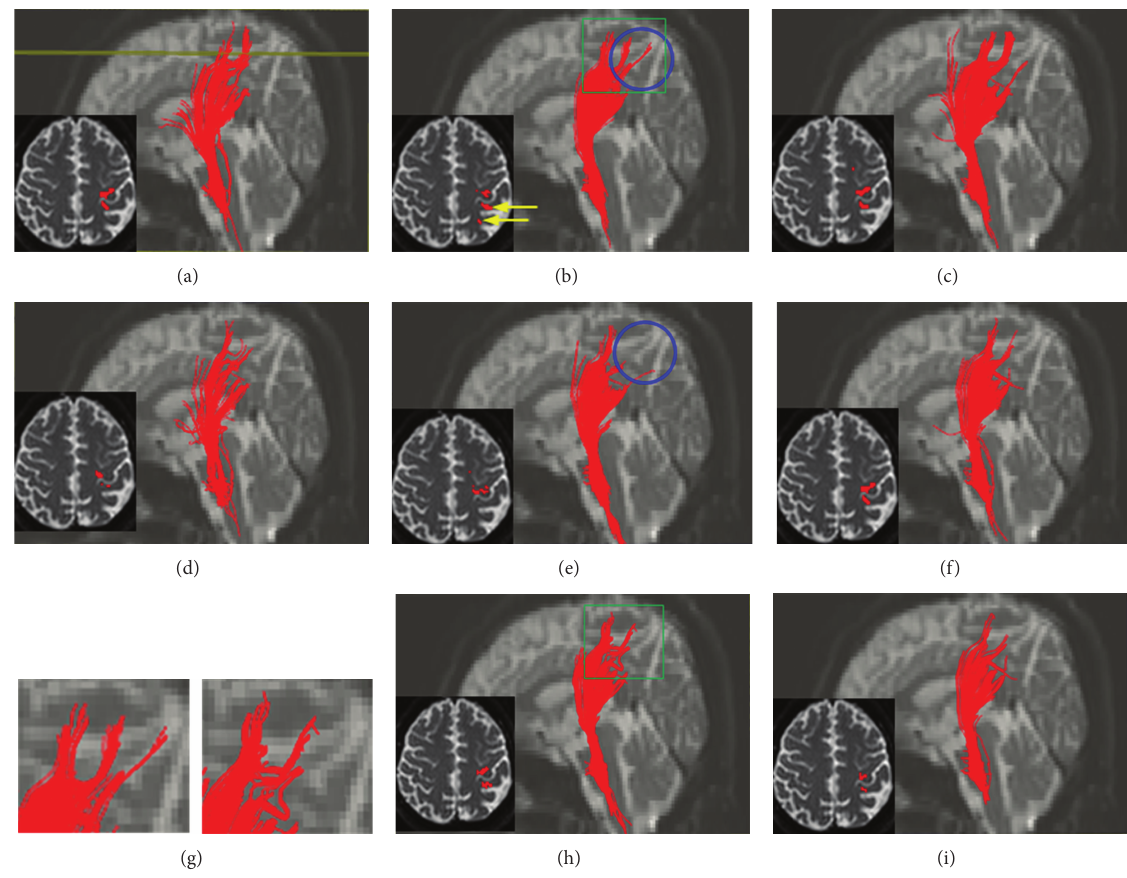
Figure 11: CSTs passing through the pons of a human subject: corticospinal tracts obtained from the original data with (a) no filter, (b) SM3D, and (c) SF3D and the CSTs obtained from the disturbed data ( 𝜎 = 0.0001) with (d) no filter, (e) SM3D, (f) SF3D, (h) SM2D, and (i) SF2D. The images in the bottom left corners show the CSTs in the axial planes represented by the horizontal line in (a). And the left figure and the right one in (g) are magnified images of the green rectangular regions in (b) and (h),